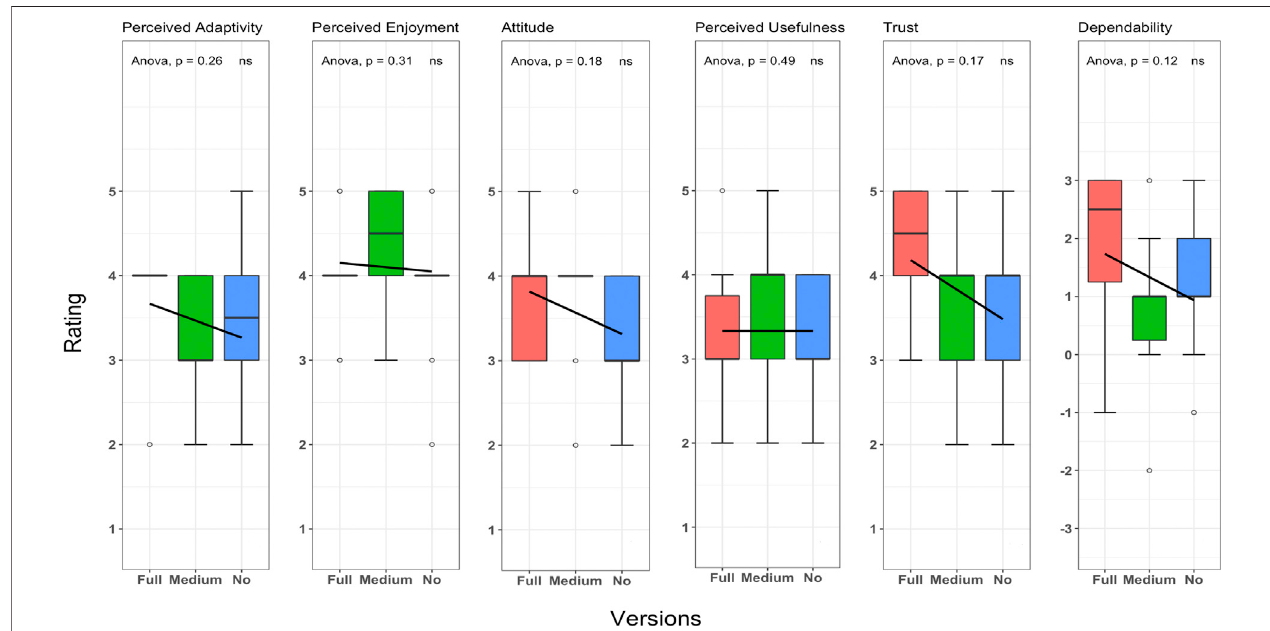
FIGURE 10 | Analysis of questionnaire; the graph visualizes the united results of the questionnaire with ANOVA and post hoc t -test analysis. The scale is a 5-point Likert scale (ALMERE), except for Dependability, which was part of another subset of the questionnaire using a 7-point Likert scale (UEQ).